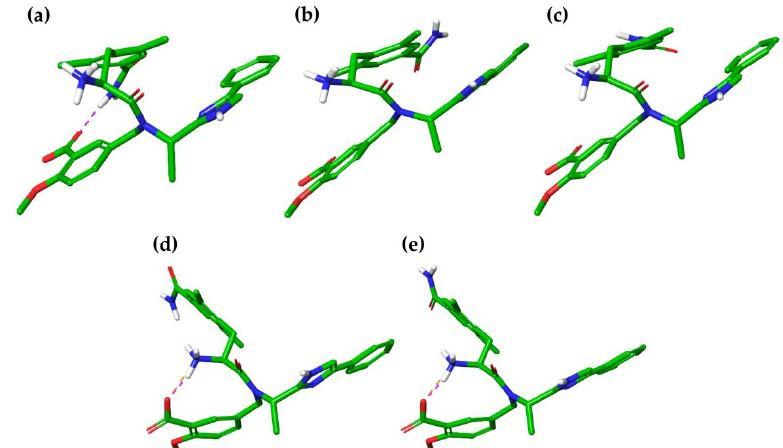
Figure 3. Three-dimensional structures of the best energy minima (%B > 10%) of E1, obtained after MD simulations conducted in both solvents. Intramolecular interactions are shown as green ( π -cation) and purple (H-bond) dash lines. ( a ) E1-MD1w , ( b ) E1-MD2w , ( c ) E1-MD3w , ( d ) E1-MD1o , and ( e ) E1-MD2o.